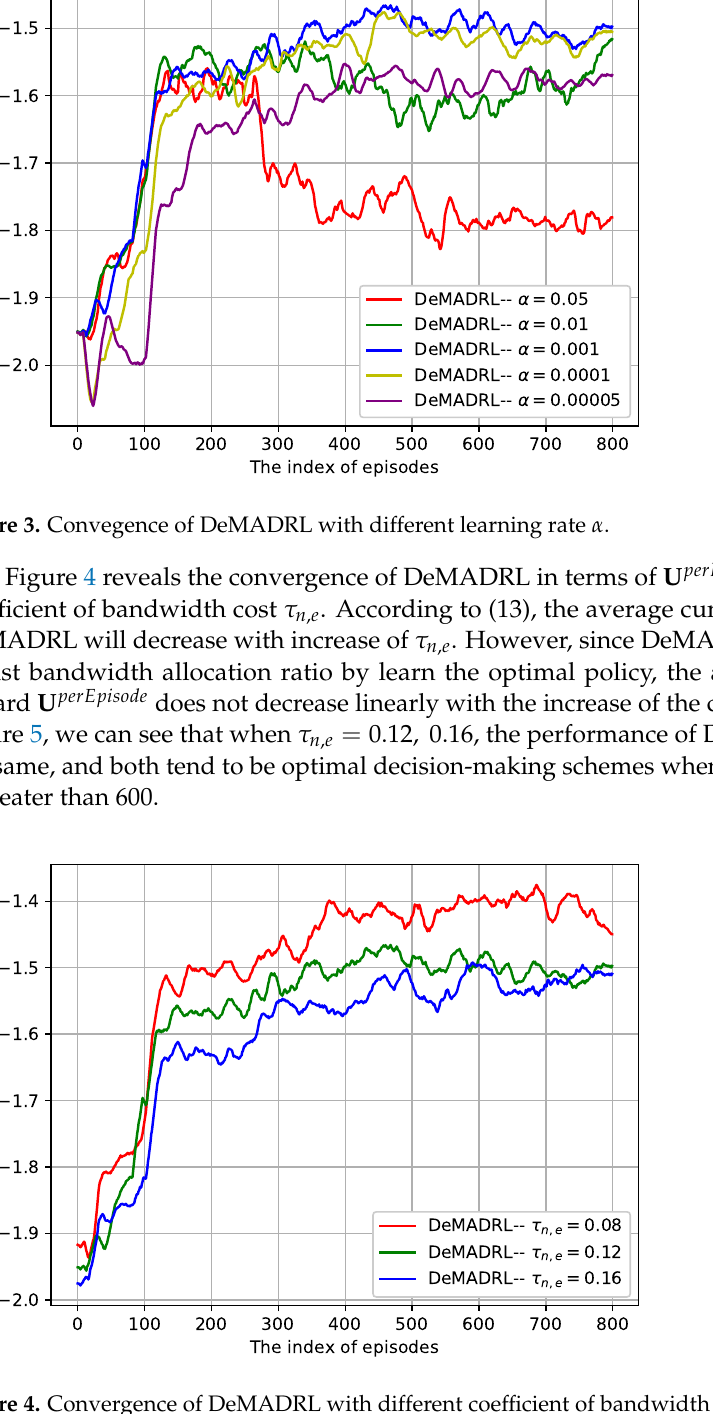
Figure 4. Convergence of DeMADRL with different coefficient of bandwidth cost τ n , e